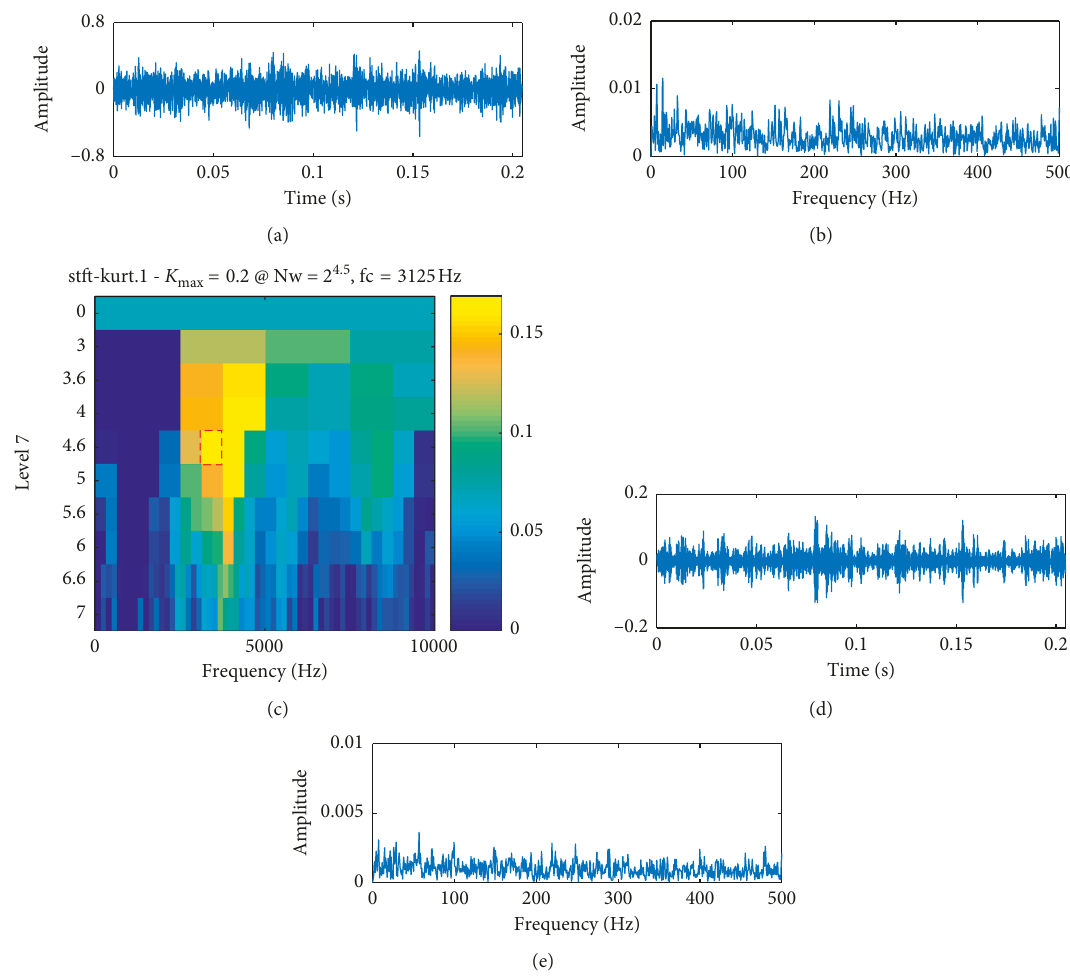
Figure 23: Diagnosis results of the life cycle fault signal by EEMD-FSK: (a) TW of the reconstruction signal obtained by EEMD; (b) ES of (a); (c) kurtogram; (d) TW of the filtered signal obtained by FSK; (e) ES of